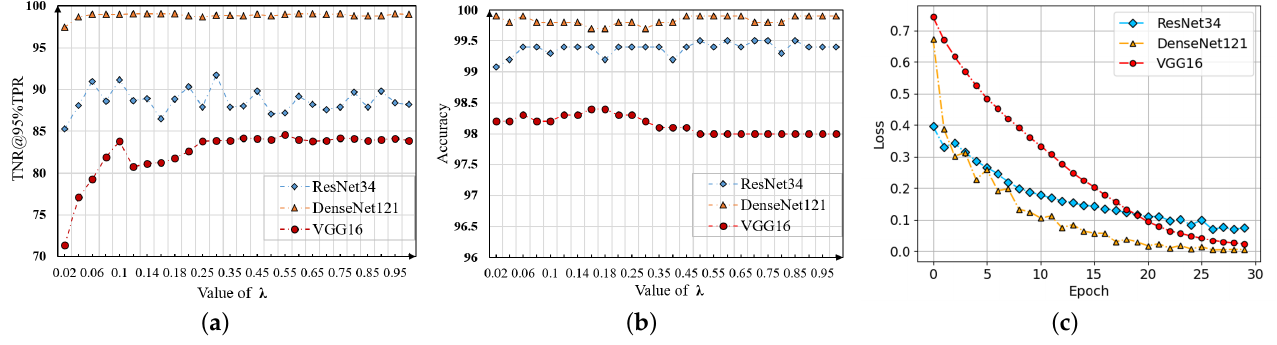
Figure 6. Sensitivity analysis. ( a ) Influence of λ on detection performance; ( b ) influence of λ on classification performance; ( c ) convergence of objective function Equation